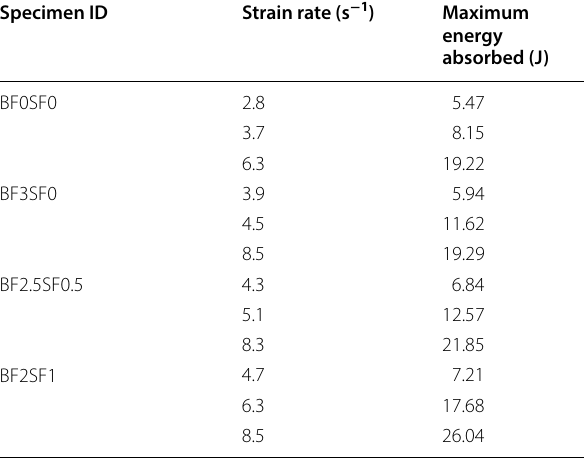
Table 7 Maximum energy absorbed for various